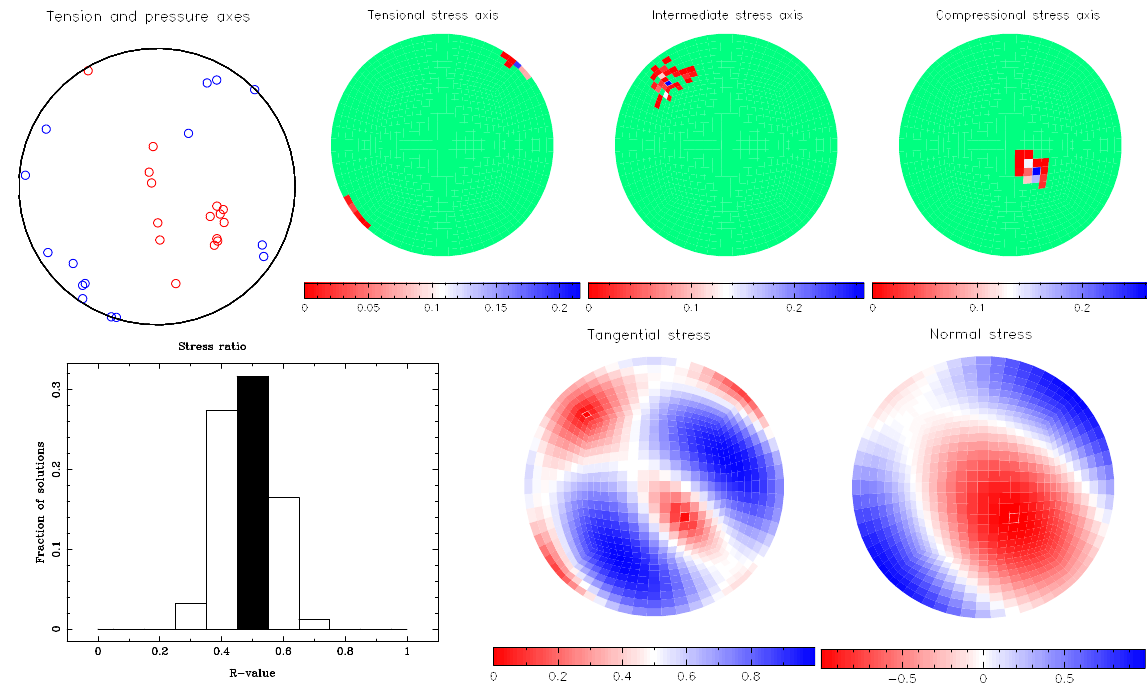
Fig. 8. Results of stress inversion for cluster of shallow earthquakes north of Karpathos. Explanation of subfigures is as in Fig. 5.